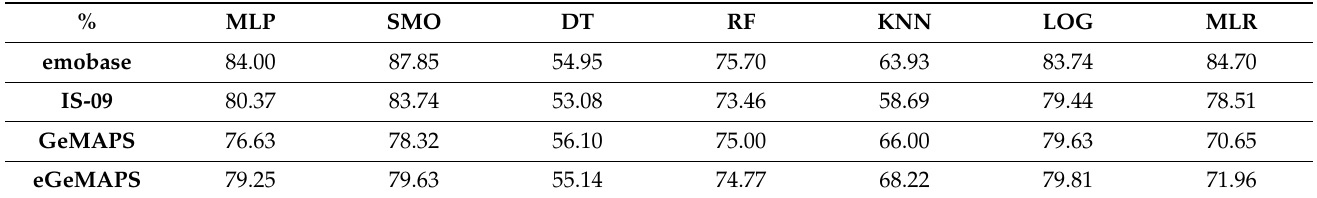
Table 3. Accuracy percentages of each classifier on each feature set. Classifier and feature set names and abbreviations are written